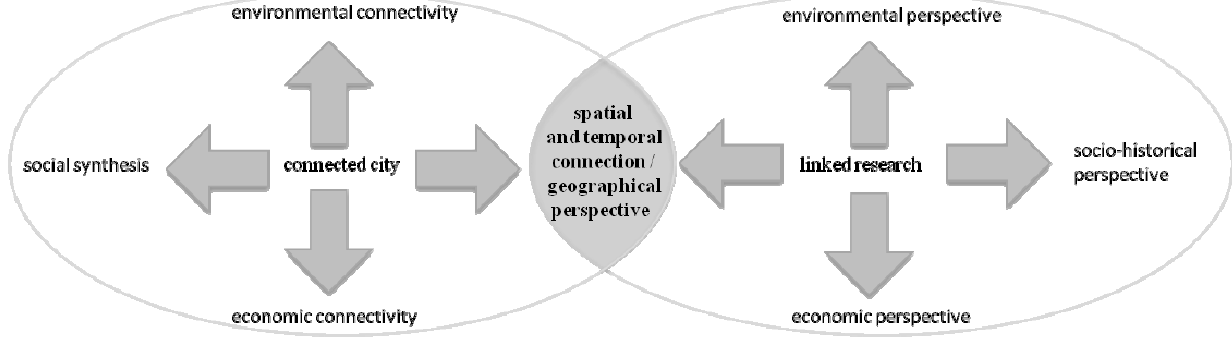
Figure 2. Concept of a holistic urban research